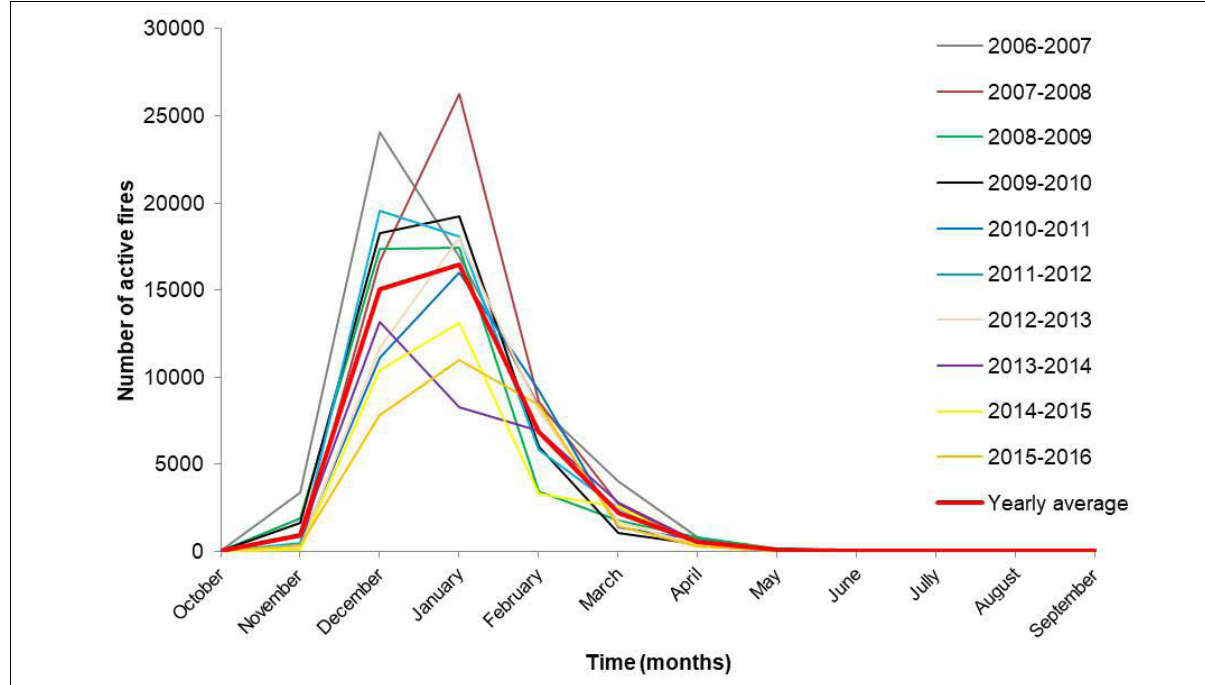
Figure 6: Temporal distribution of active fires in Côte d’Ivoire by month from 2007 to